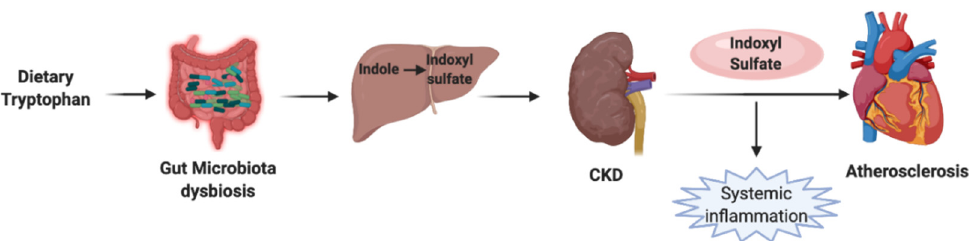
Figure 3. Effect of Indoxyl sulfate in atherosclerosis. Schematic presentation of the Indoxyl sulfate pathway is linked to atherosclerosis. Tryptophan is metabolized by the gut microbiota into indole, and indole is absorbed into the circulation. In the liver, indole is metabolized to indoxyl sulfate. In chronic kidney disease and dysbiosis conditions, kidneys are incapable of clearing indoxyl sulfate. This results in the accumulation of indoxyl sulfate. Systemic inflammation caused by indoxyl sulfate can cause coronary calcification and chronic cardiovascular abnormalities, eventually leading to atherosclerosis.